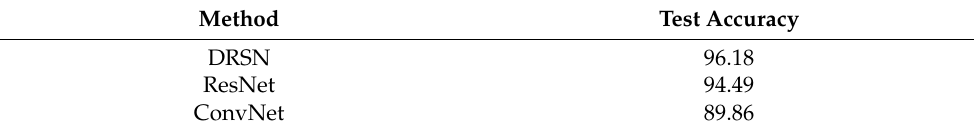
Table 5. Average accuracies of the DRSN, ResNet and ConvNet with Laplacian noise (%).